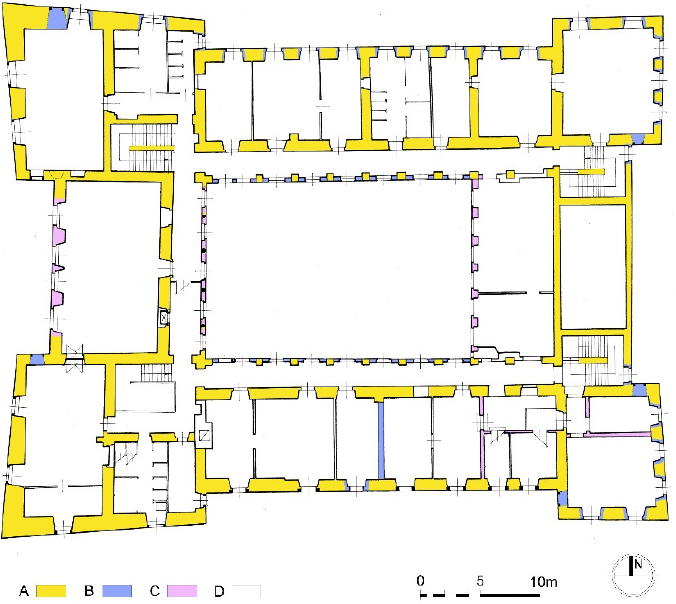
Figure 9. Prószków castle: first floor plan with chronological stratification of the walls. Legend: A—Renaissance (approximately 1563); B—Baroque (1667–86); C—1881; D—walls unknown and from the 20th century, created by authors.